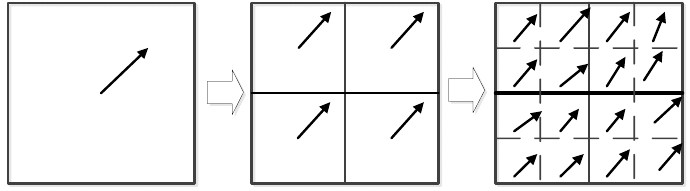
Figure 5. The basic principle of the iterative multi-grid interrogation process. Additionally, particle image density can affect the choice of the final interrogation window size. When the particle image density or the number of particles decreases to a certain extent in the targeted interrogation window, the detection rate will decrease rap- idly. The detecting speed, that is, the calculated feature vector, may be increased signifi- cantly by downsampling the image during the initial interrogation process at the same time. It can be realized by merging neighboring pixels by using the sum of N × N block pixels. This process can help the detection process become much faster when using inter- rogation samples [36].